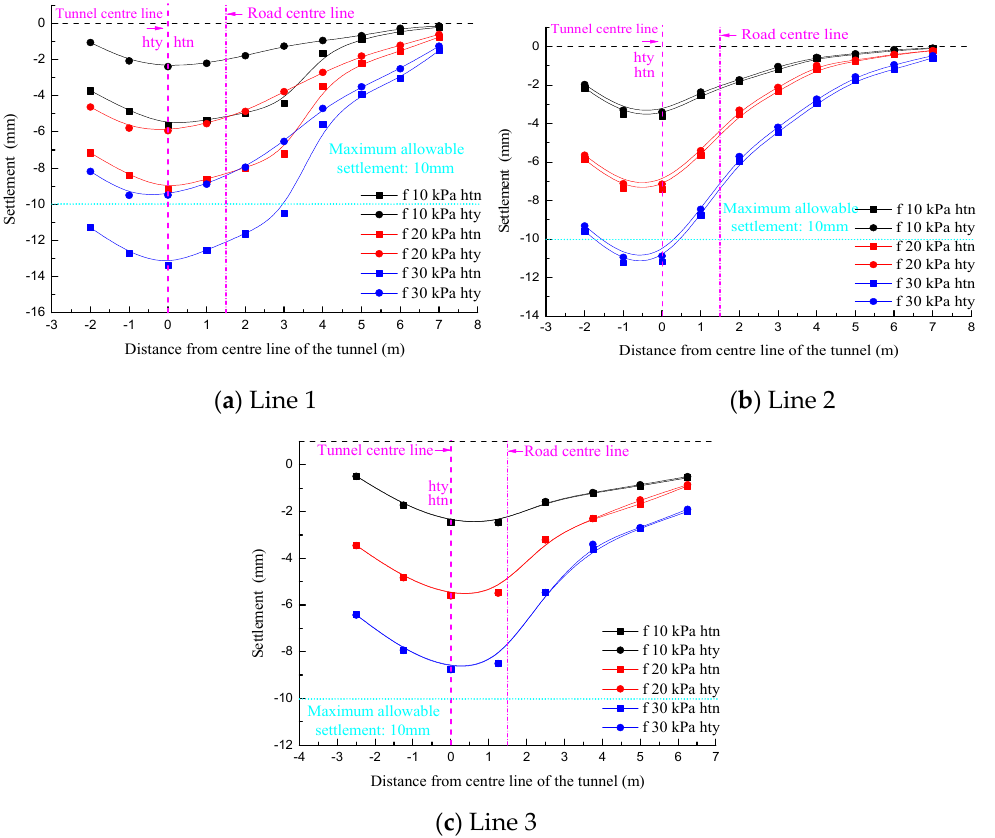
Figure 16. Longitudinal surface settlement of model F-F with D/W = 0.124.